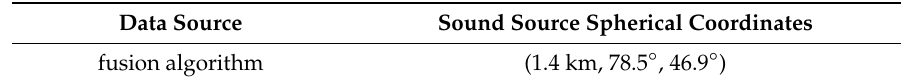
Table 8. Second experimental results.